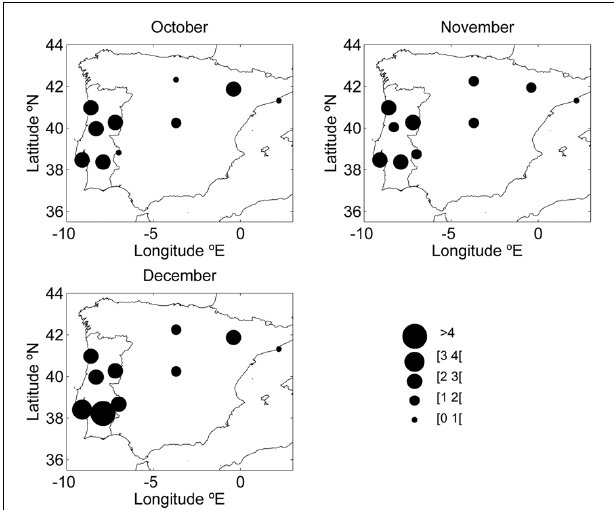
FIGURE 7 | Precipitation ratio in October, November and December 1876 when compared to the 1971–2000 average in several stations (Porto, Guarda, Coimbra, Lisbon, Evora, Badajoz, Madrid, Burgos, and Huesca). The climatological data for Spanish stations was obtained from Aemet (Agencia Estatal de Meteorología), and for Portuguese stations from IPMA (Portuguese Sea and Atmosphere